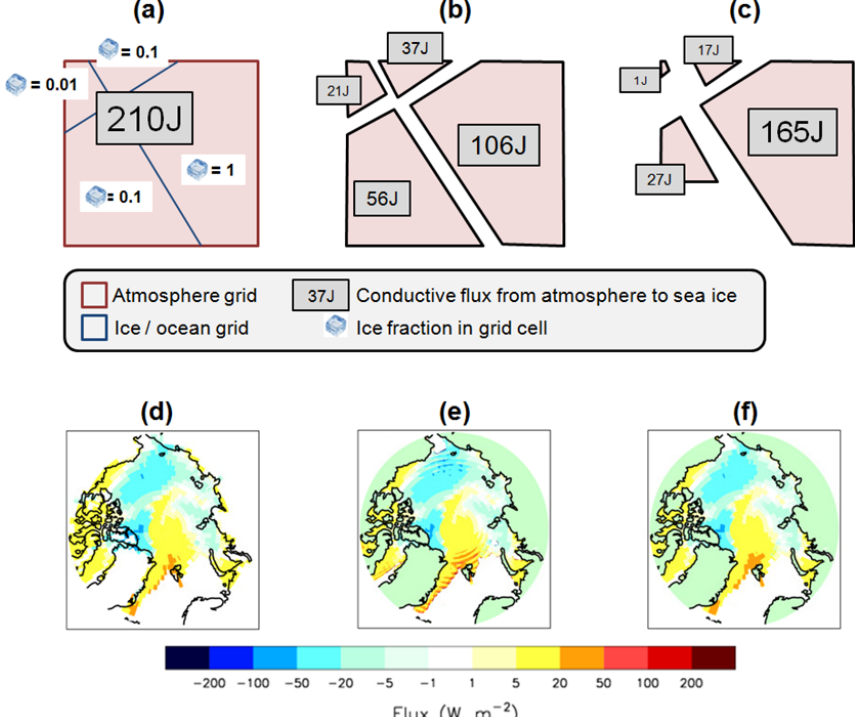
Figure 2. Demonstrating the implementation and effect, of semi-implicit coupling within the CICE-JULES surface exchange scheme. Panel (a) shows an example atmospheric grid cell overlying four ice/ocean grid cells calculates a sea ice conductive flux representing 210J energy; (b) the division of energy between cells with standard coupling, in proportion to grid cell area; (c) the division with semi-implicit coupling, in proportion to ice area. (d) shows a conductive flux field on the atmosphere grid; the resulting flux field on the sea ice grid is shown for (e) standard coupling and (f) semi-implicit